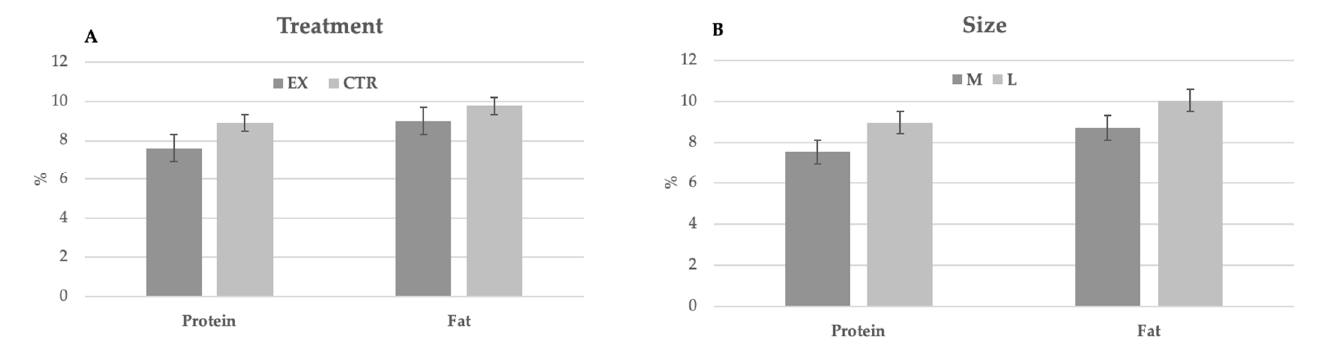
Figure 1. Milk chemical composition (% as fed, mean ± SD) of CTR group (n = 9) and EX group (n = 9) in function of the diets ( A ) and the size ( B ).